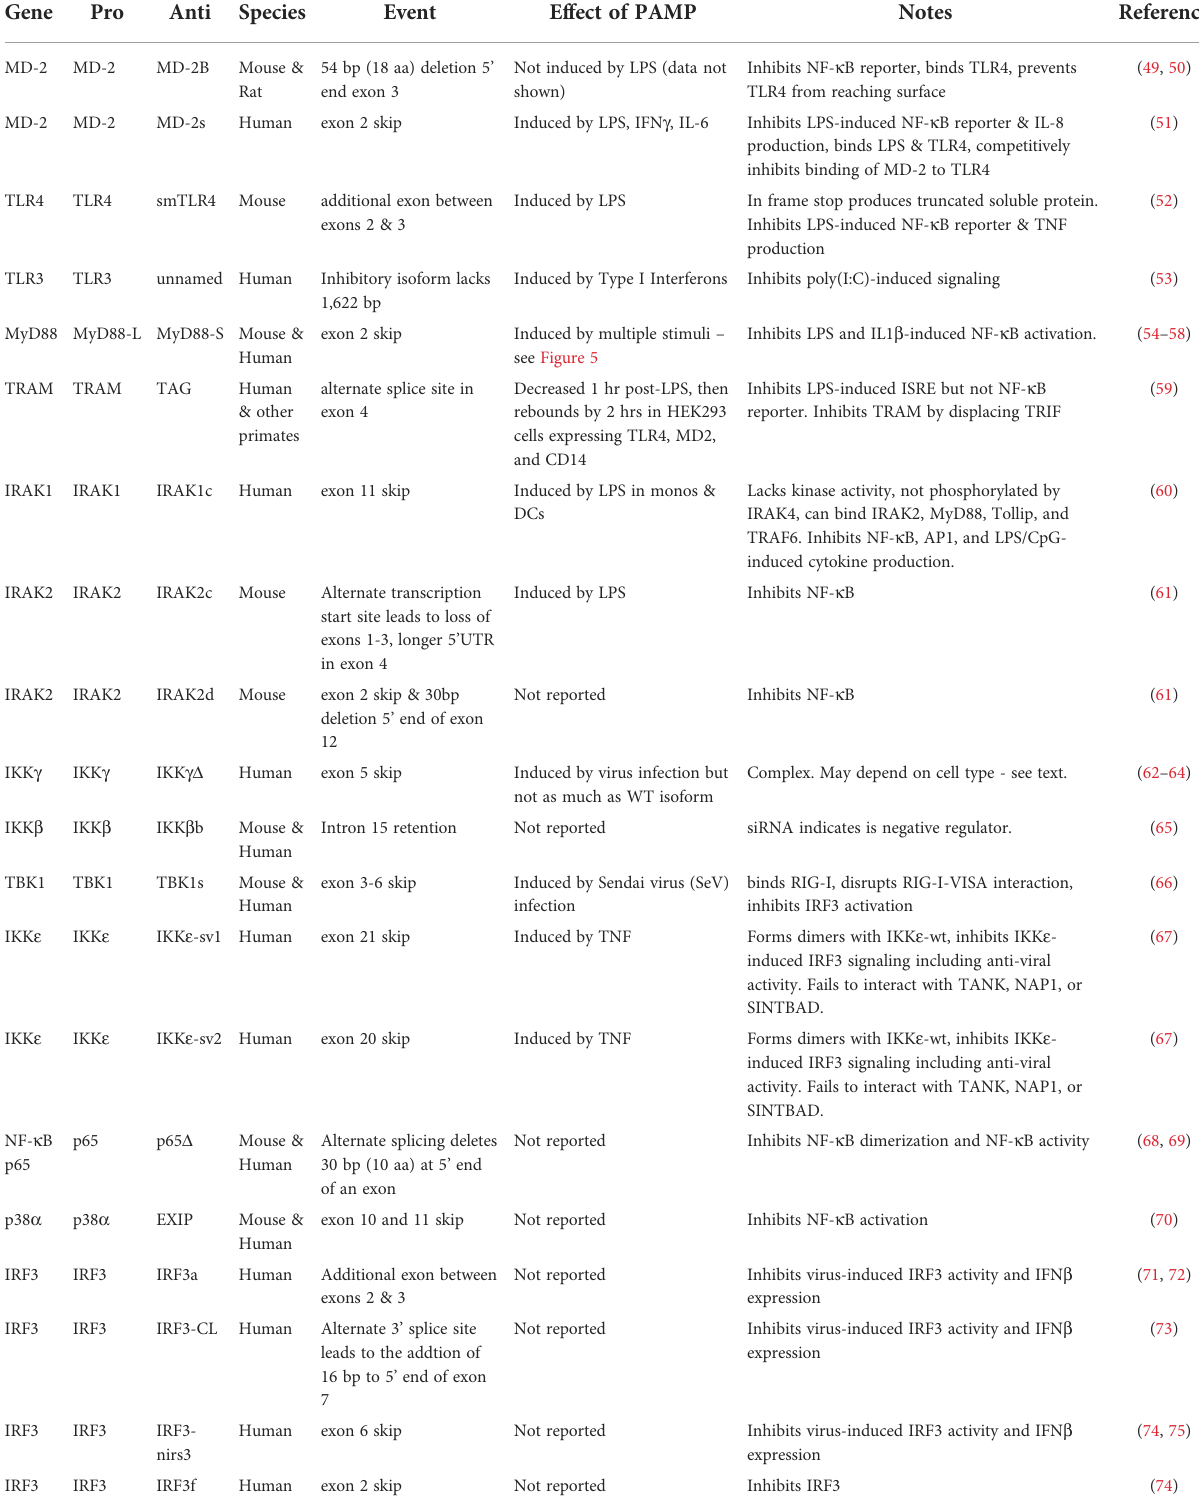
TABLE 1 Alternate splice forms that encode negative regulators in the TLR signaling pathway.